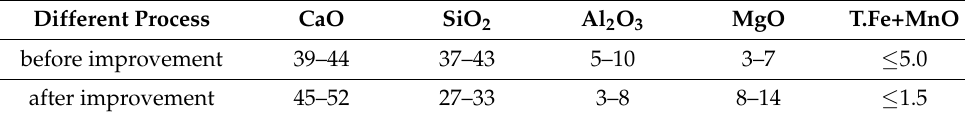
Table 4. Components of the refining slag in LF before and after improvement, wt%.